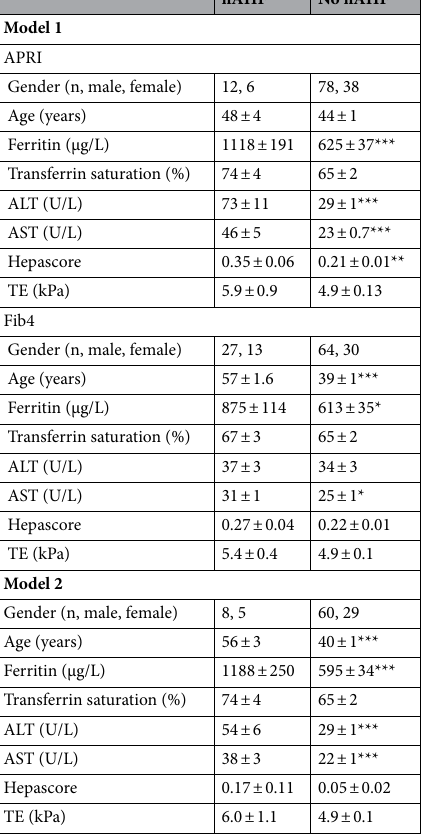
Table 2. Characteristics of study subjects in Model 1 (APRI or Fib4) and Model 2 (combined APRI and Fib4 scores). All data are presented as the mean ± SE. ALT: alanine aminotransferase; APRI: aspartate aminotransferase to platelet ratio index; AST: aspartate aminotransferase; Fib4: fibrosis-4; GGT: gamma- glutamyl transferase; nAHF: noninvasive biomarker advanced hepatic fibrosis; No nAHF: no noninvasive biomarker advanced hepatic fibrosis; TE: transient elastography. *P < 0.05, **P < 0.01, ***P < 0.0001 compared with nAHF group (unpaired t